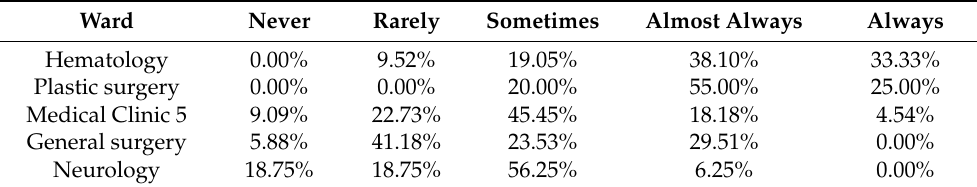
Table 5. Significant differences in response to question